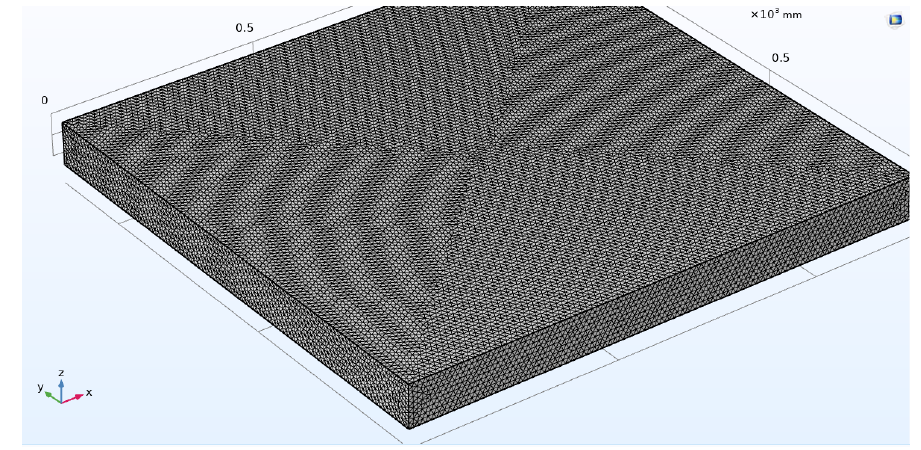
Figure 5. The meshing of the mechanical model.